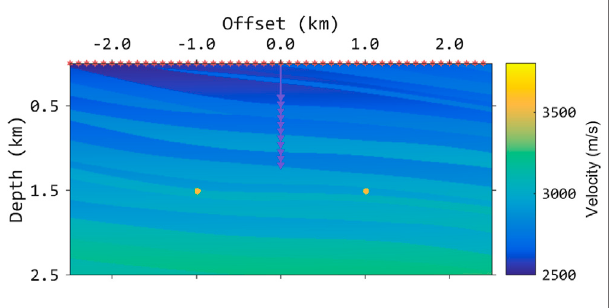
FIGURE 2 | A part of Sigsbee 2A model. The VSP survey consists of 80 geophones evenly placed in the borehole between a depth of 400 – 1,200 m. 500 shots are evenly located at the surface.